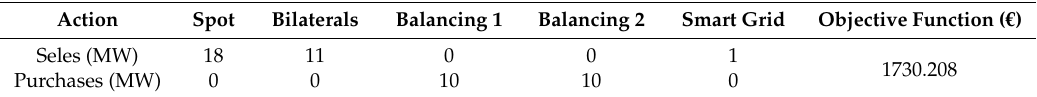
Table 1. Results for initial